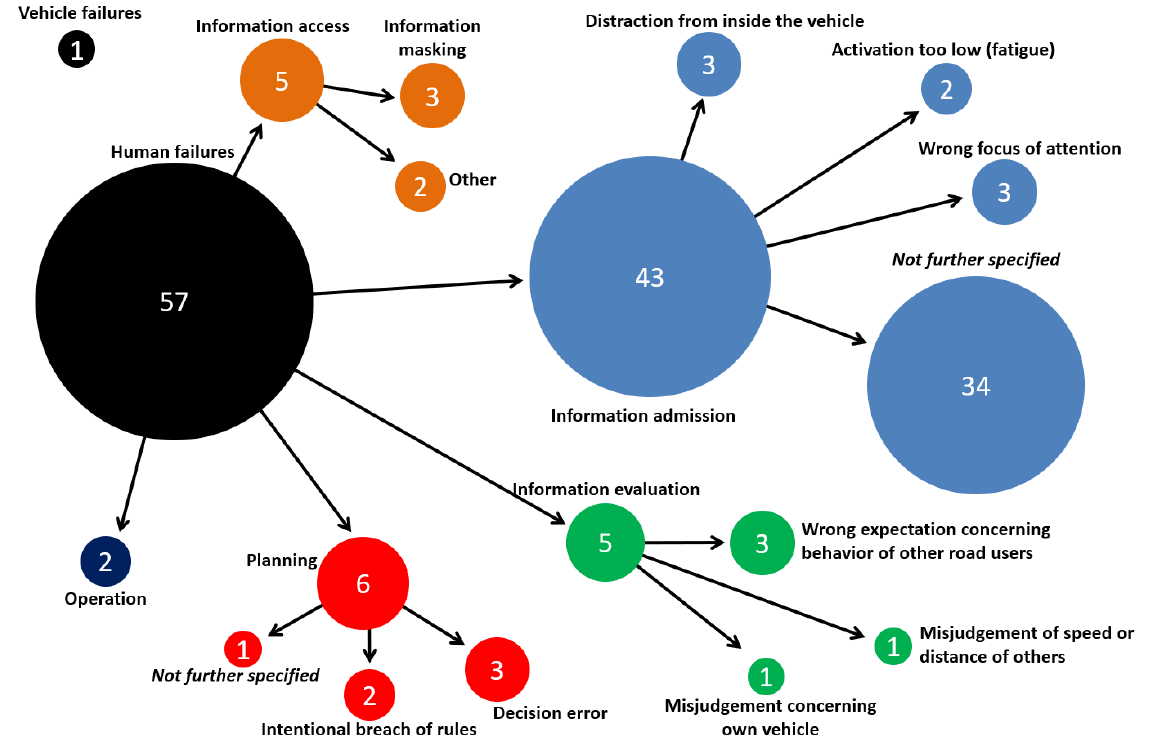
Figure 9. ACAS analysis of truck drivers in scenario 1 (rear-end striking crashes).